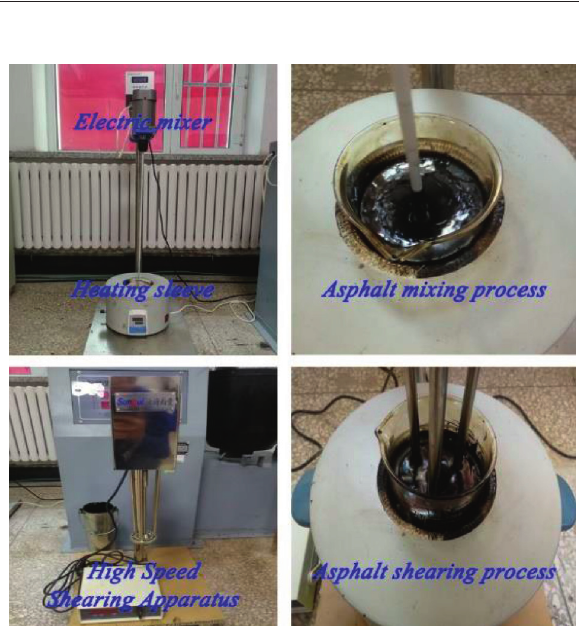
Figure 1: Mixing and shearing of modified asphalt.